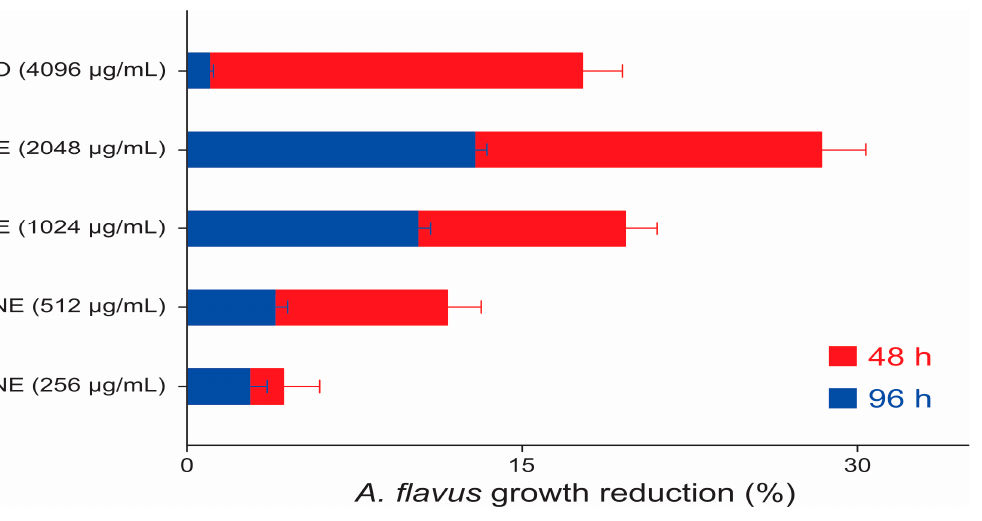
Figure 3. Inhibition of the A. flavus colonies by the concentrations of EO and NE at 48 and 96 h. Figure 4 compares the control colony and the colony with NE at 2048 µ g/mL, showing a significant result. The photos were taken with a 48 h growth time and no difference